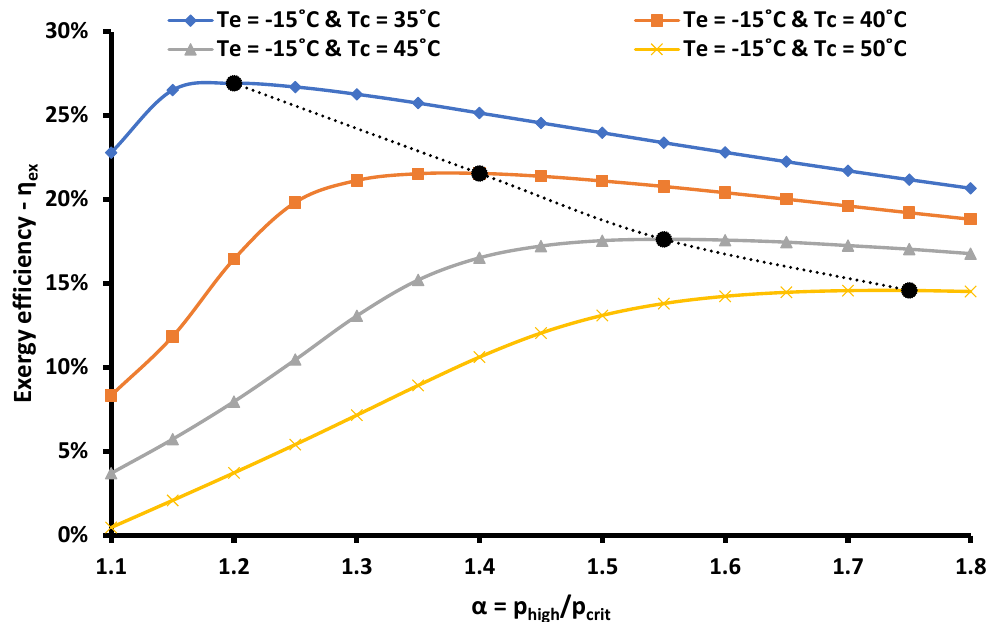
Figure 6. The impact of the pressure ratio parameter of the reference system in exergy efficiency. The black solid points show the maximum exergy efficiency and the dotted line shows the geometric location of the maximum values (T e = − 15 °C).